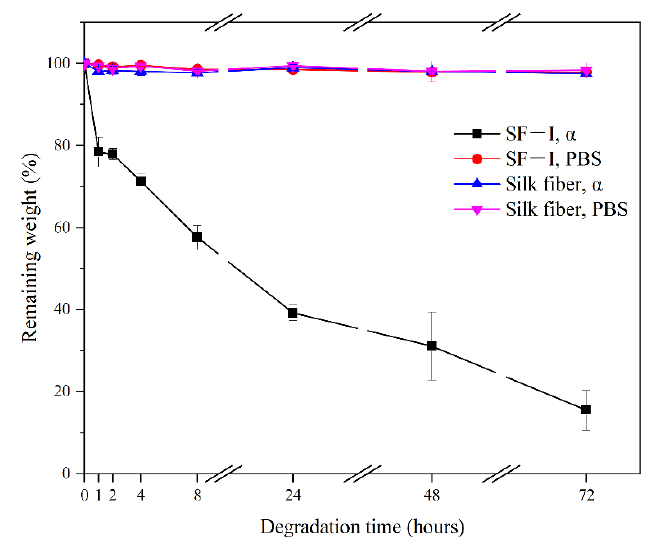
Figure 8. Enzymatic and PBS degradation curves of different silk fibroin materials (SF-I and silk fibers).